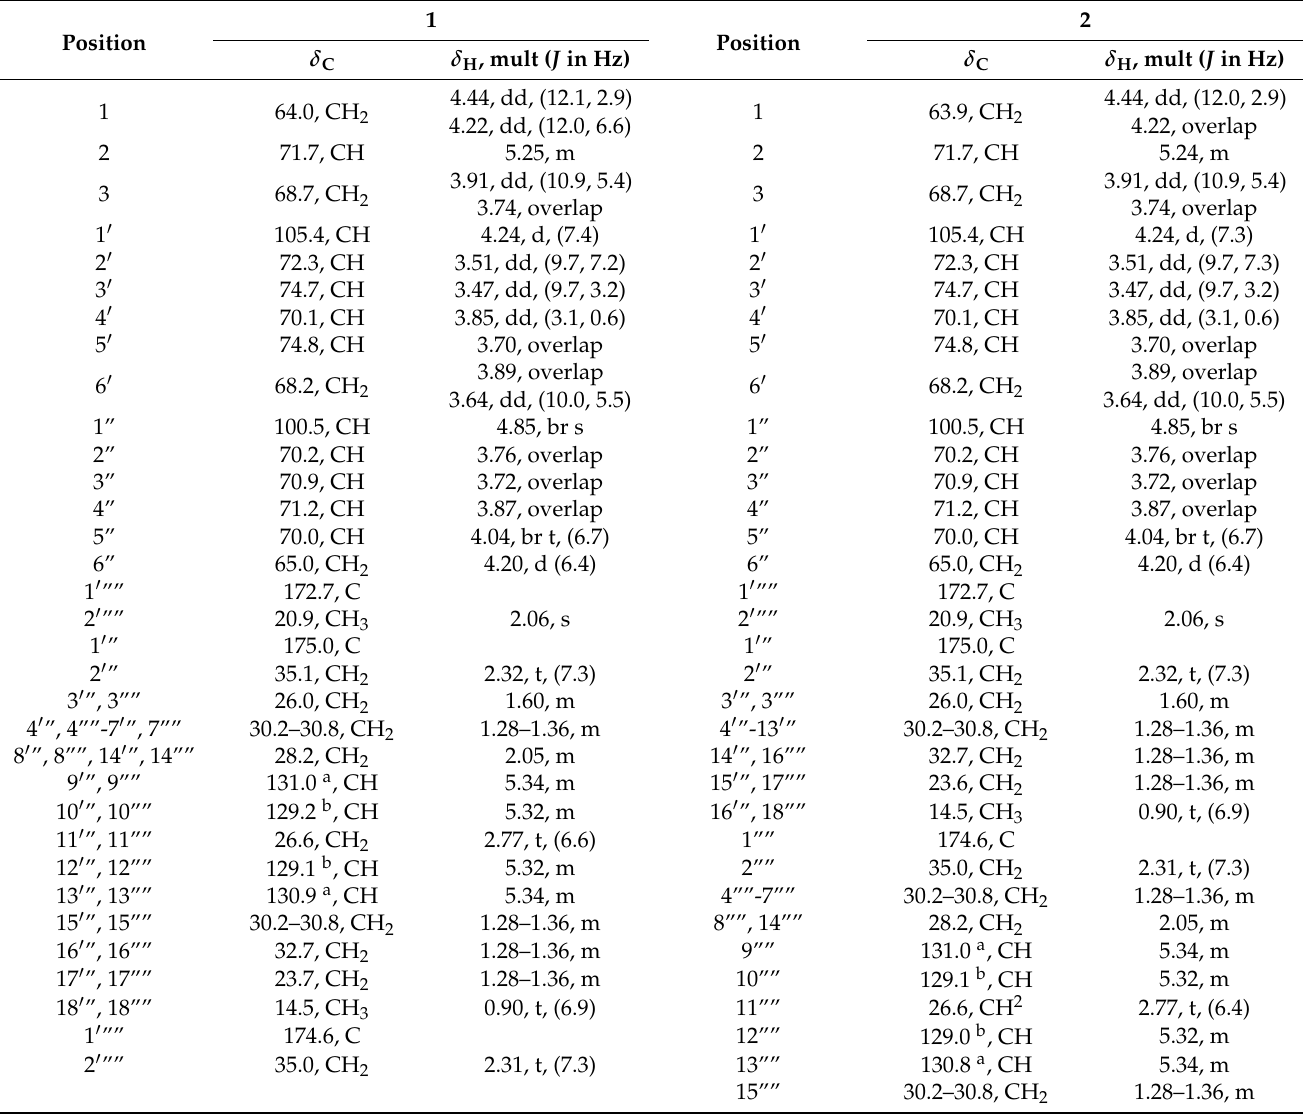
Table 1. 1D NMR data of Rubracin D ( 1 ) and E ( 2 ) in MeOD ( 1 H-NMR at 500 MHz; 13 C-NMR at 125